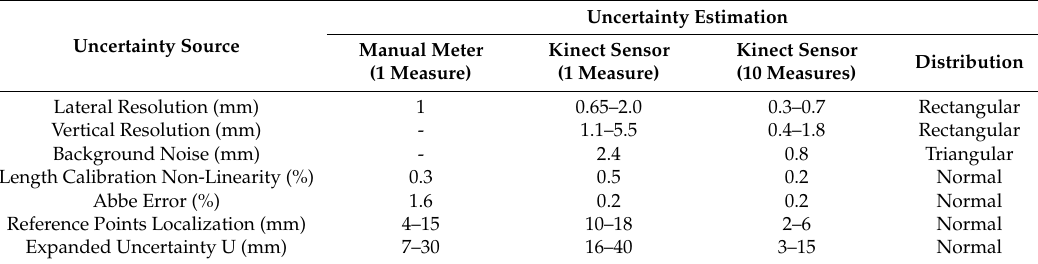
Table 2. Uncertainty